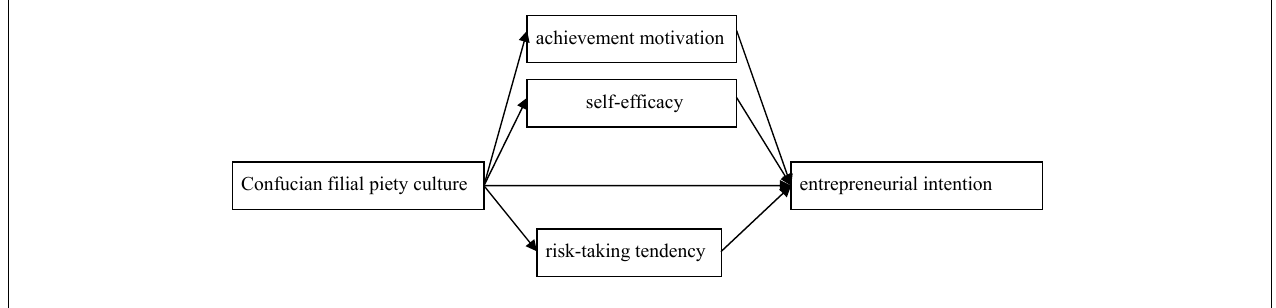
FIGURE 1 | Research framework.